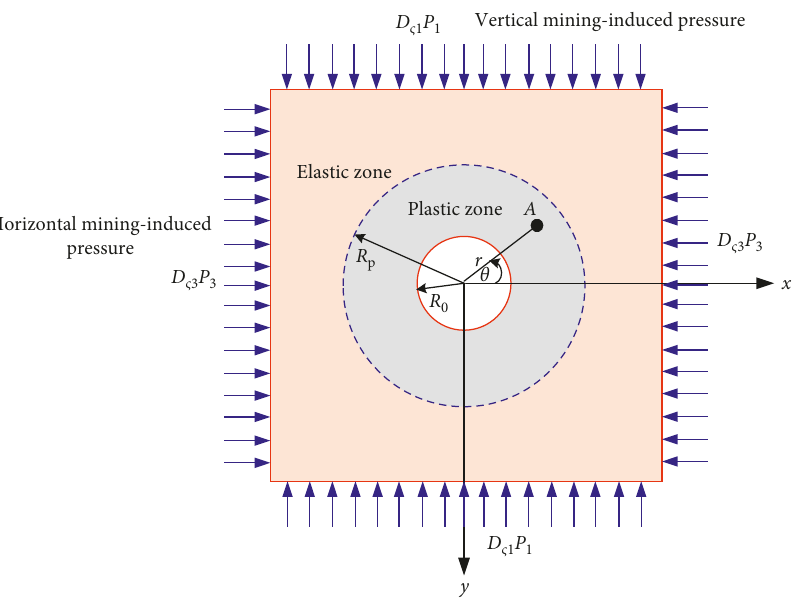
Figure 2: Mechanical model of the